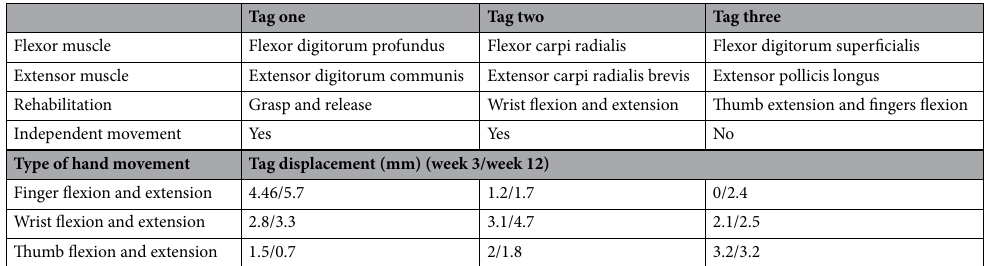
Table 1. Transferred muscles data and tag displacement outcomes.